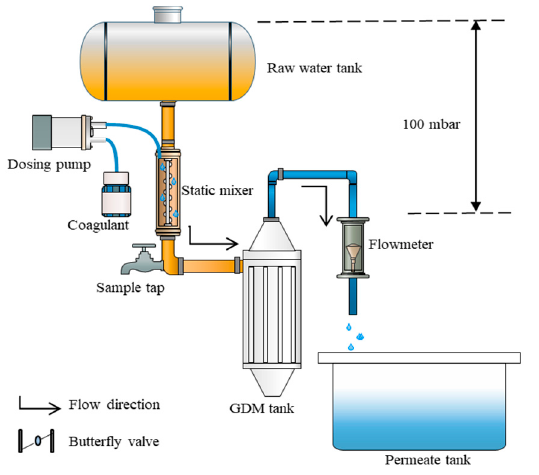
Figure 1. Schematic flow diagram of the coagulation / GDM system. Note: GDM = gravity-driven